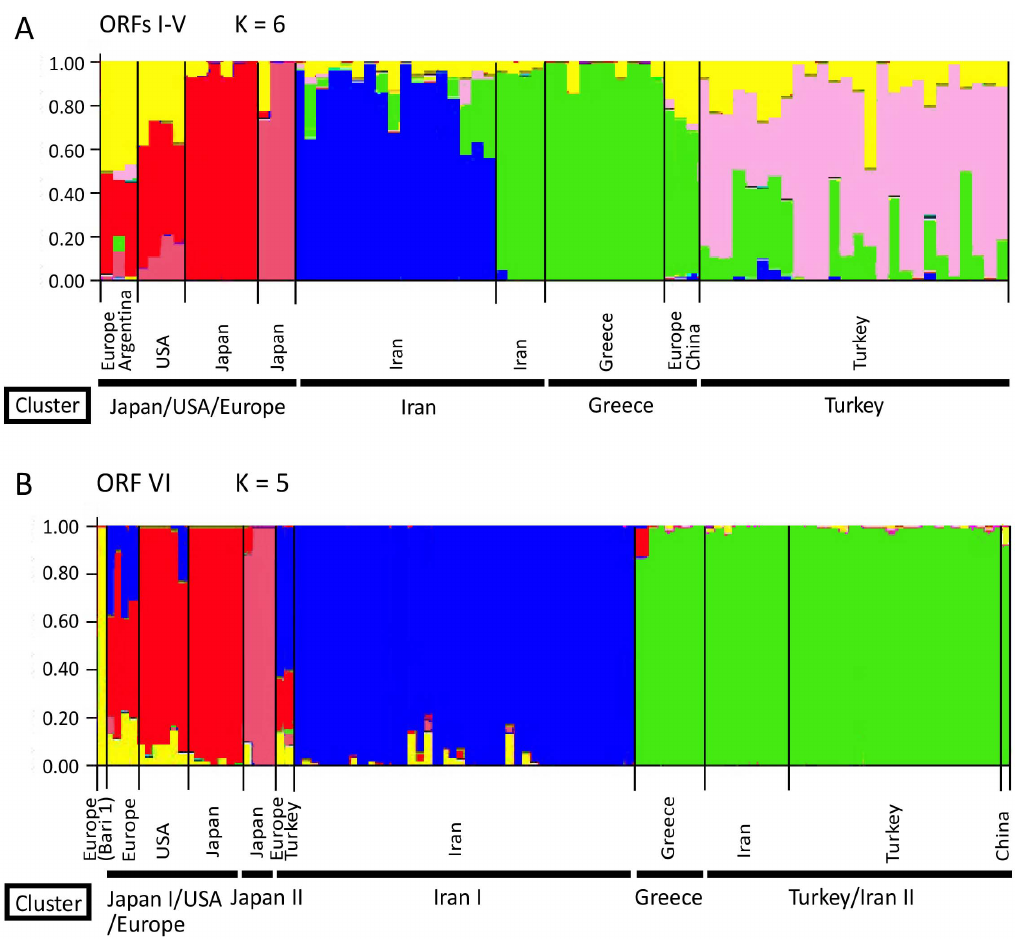
Figure 2. Cluster-based analysis of population subdivision using Structure. The results are grouped by population of origin for each individual. Each individual is represented by a column. The number of clusters is indicated by the value of K : ORFs I–V, K =6 (A), ORF VI, K =5 (B). The colour proportion for each bar represents the posterior probability of assignment of each individual to one of six clusters (A) and one of five clusters (B) of genetic similarity. Clusterings correspond to those shown in Figure S1 in File S1.